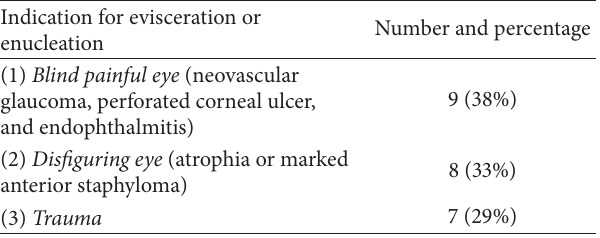
Table 2: Depicting indications for evisceration and enucleation in patient